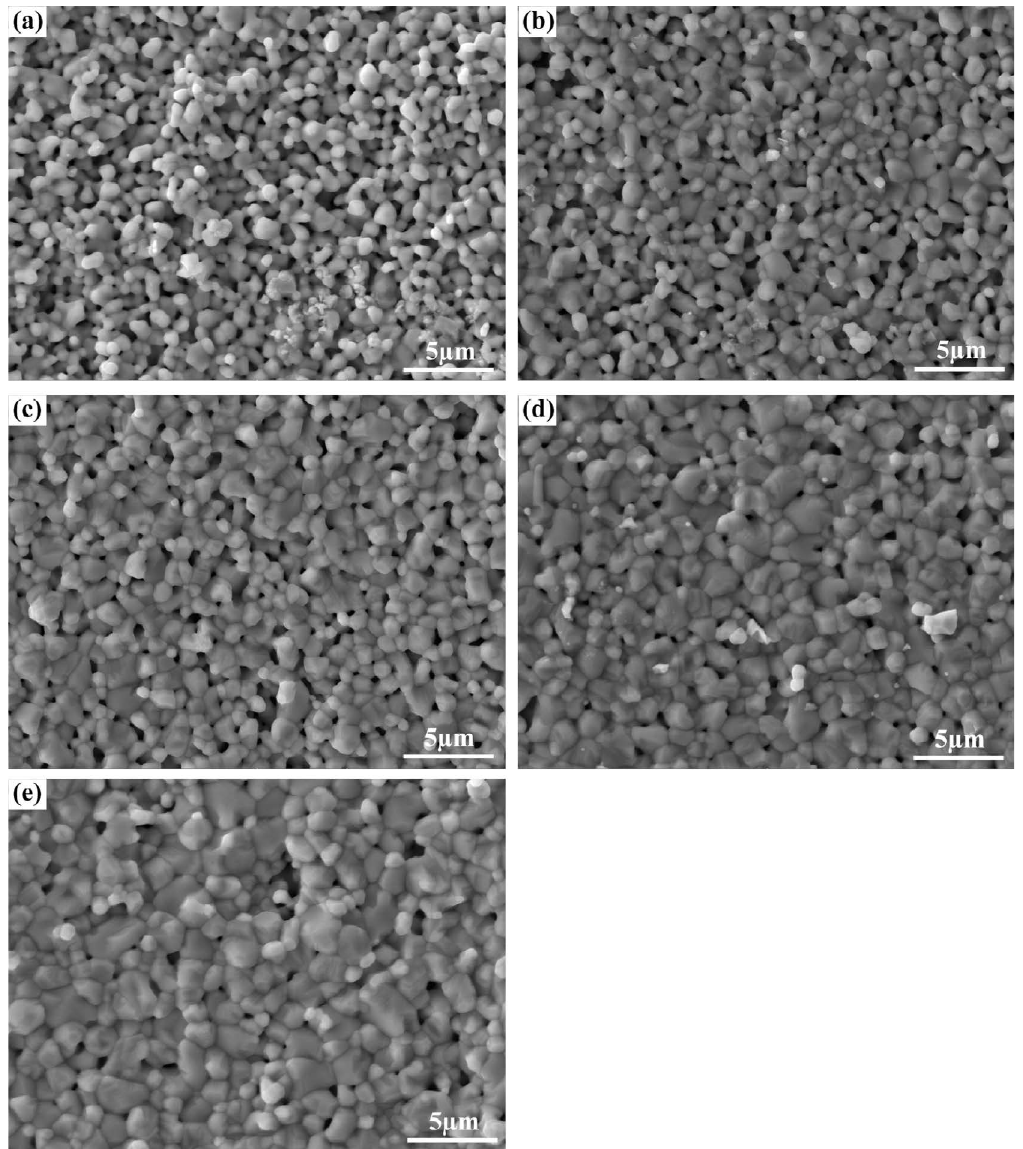
Figure 1. The SEM micrograph on the surfaces of the as-sintered specimens sintered at 1190 °C with different sintering time; (a) 0.5 h, (b) 1 h, (c) 2 h, (d) 4 h, (e) 6